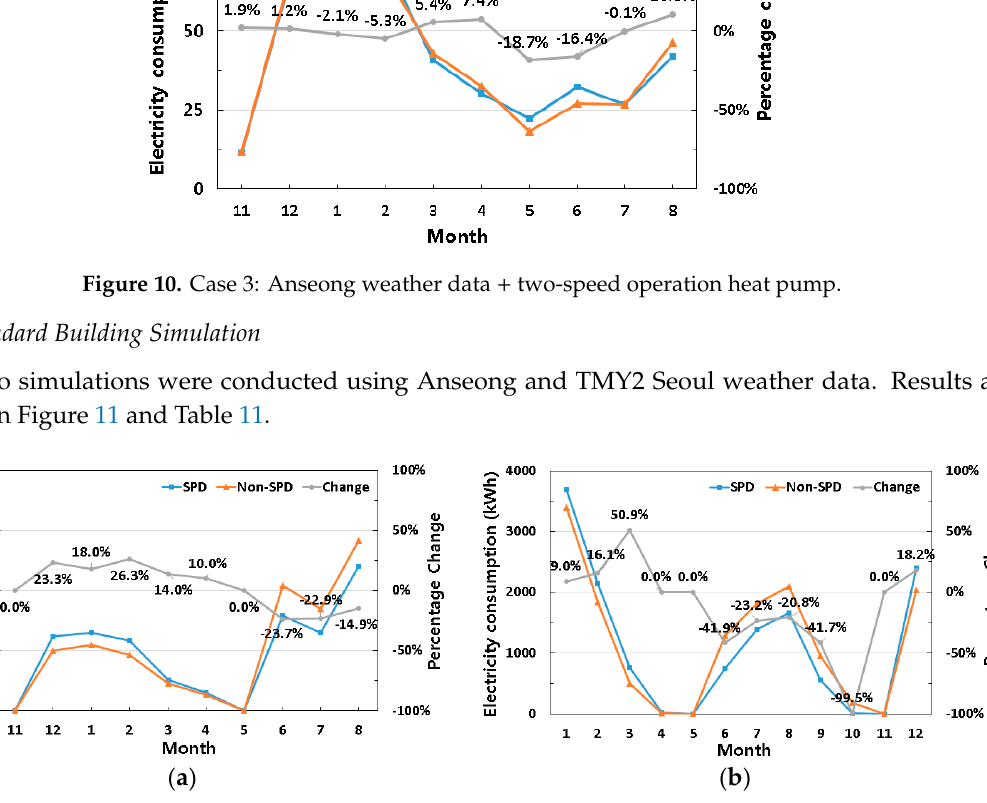
Figure 11. Comparison of heat-pump power consumption between SPD windows and non-SPD windows (standard building): ( a ) measured weather data in Anseong; ( b ) TMY2 Seoul Table 11. Percent change and cooling/heating electricity consumption of SPD model compared with the non-SPD model (standard building).